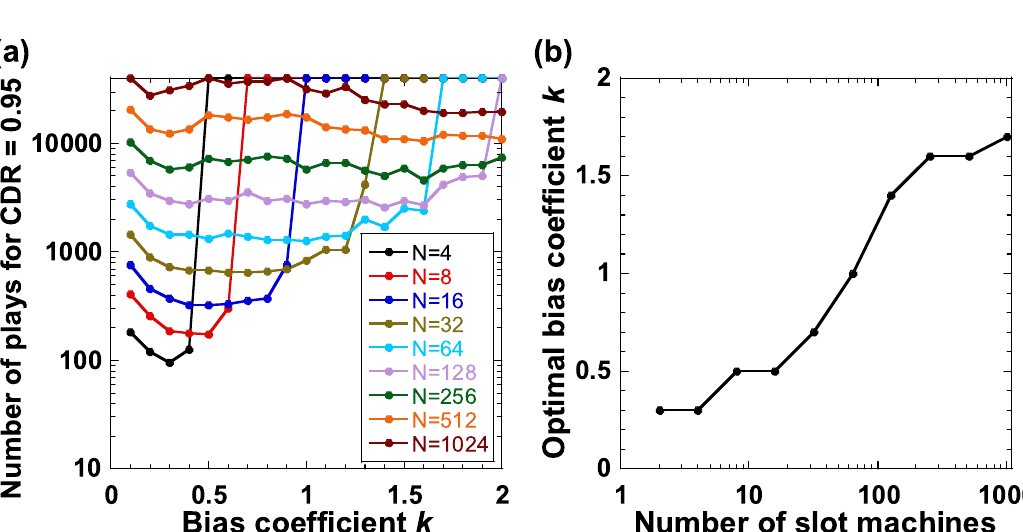
Figure 7. Optimization of bias coefficient k for different numbers of slot machines N . ( a ) Number of plays to achieve CDR = 0.95 as the bias coefficient k increases for different values of N . ( b ) Optimal bias coefficient k for different values of N obtained from ( a